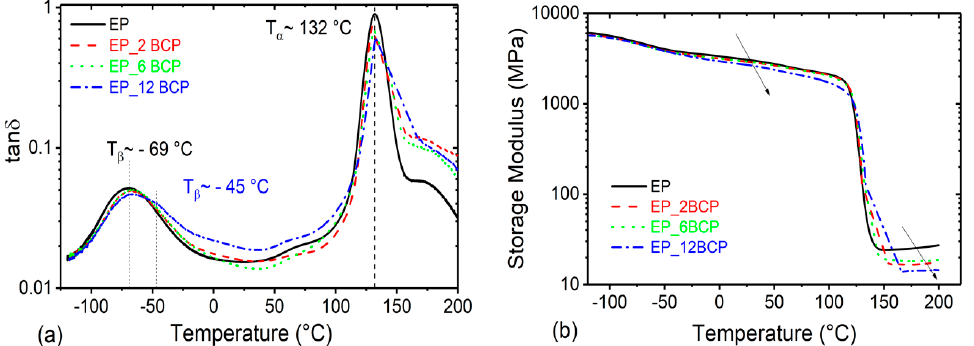
Figure 3 . Graph showing ( a ) tan δ and ( b ) storage modulus, with respect to temperature for the EP_BCP systems.